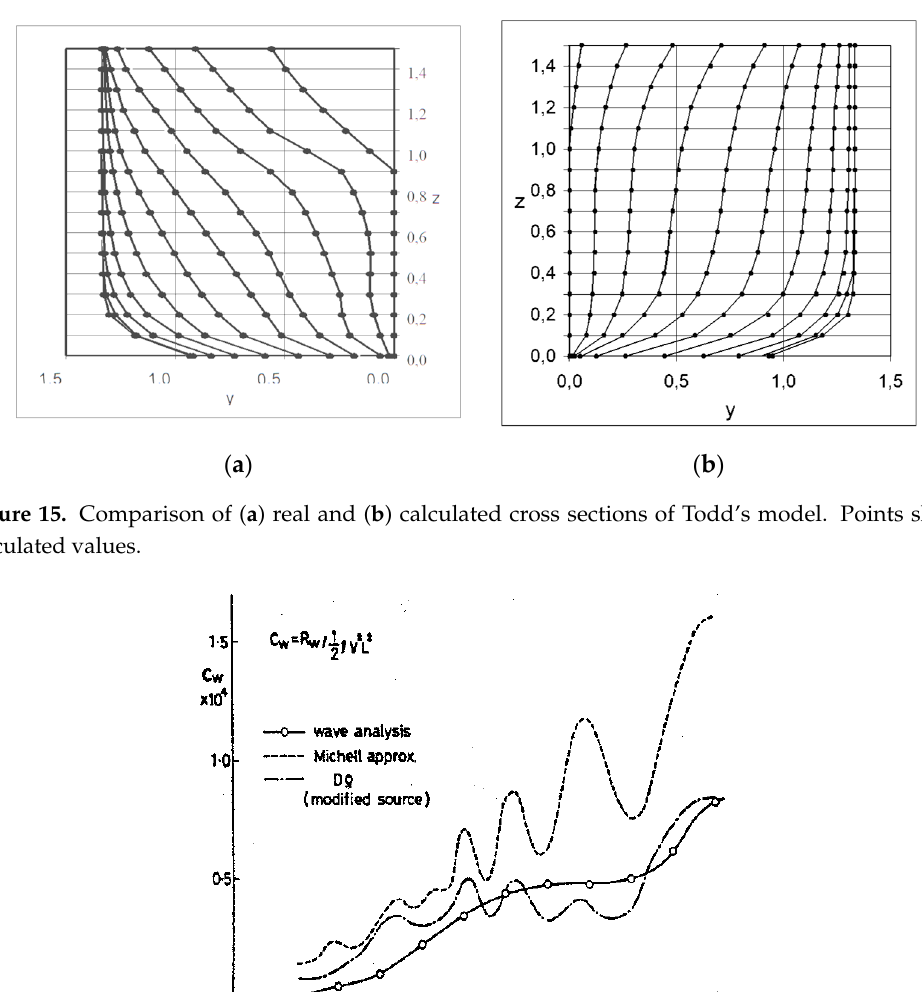
Figure 16. Comparison of wave pattern resistance of WM1 (This is Figure 16 in